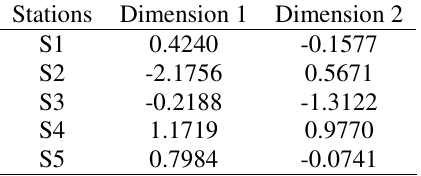
Table 2. Multidimensional scaling analysis coordinate values of the monitoring stations